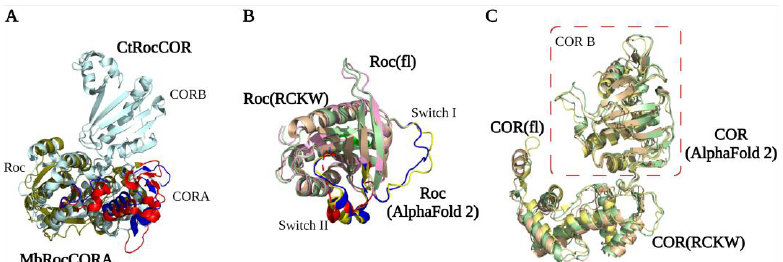
Figure 3. RocCOR tandem structures. ( A ) Alignment of the Mb (PDB ID: 4WNR) and Ct (PDB ID: 3DPU) RocCOR domains in dark green and light blue respectively. The rearrangement of P-loop, switch II, and CORA domain are indicated in red ( Mb RocCORA) and blue ( Ct RocCOR). ( B , C ) Alignment of the Roc/COR domain from LRRK2 RCKW (PDB ID: 6VP7) (light yellow), flLRRK2 (PDB ID: 7LHW) (pink), and AlphaFold2 (green). The partly and totally missed switch I/II in LRRK2 RCKW are highlighted in blue (flLRRK2), red (LRRK2 RCKW ), and yellow (AlphaFold2), respectively.